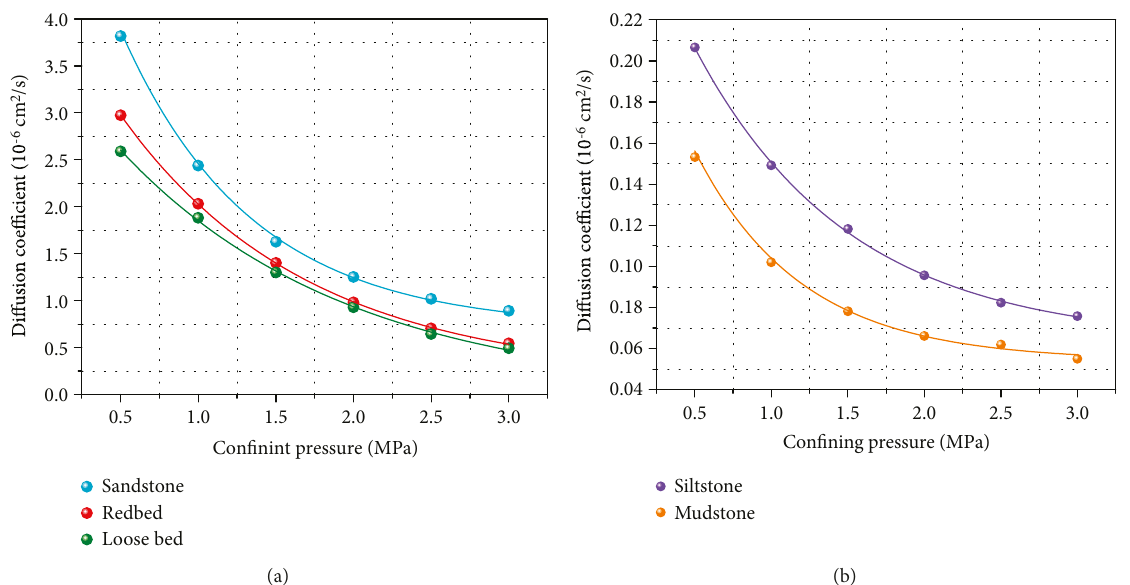
Figure 8: Di ff usion coe ffi cient of cap rock samples under di ff erent con fi ning pressures. Note: loose bed refers to Quaternary and Neogene rocks; Redbed refers to Paleogene rock. The data points were derived from the average values of six surface drilling holes (75-7, 74-7, 74- 11, 67-11, 73-14, and 75-8) that were calculated by the di ff usion coe ffi cients of the coal-bearing rocks (sandstone, mudstone, and siltstone), Paleogene rocks (Redbed), and Neogene and Quaternary rocks (Loose bed).